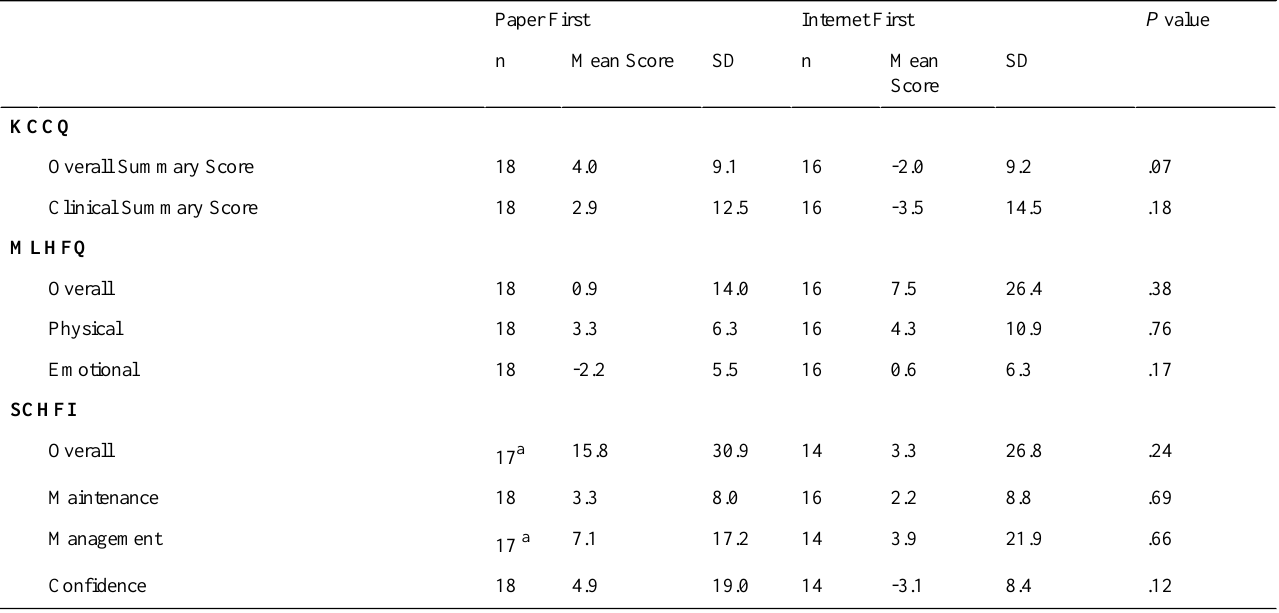
Table 3. Effect of order of administration on mean paired differences for the three questionnaires